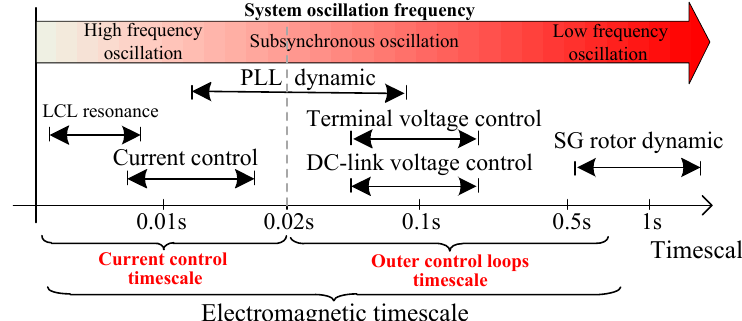
Figure 2. Timescale decomposition in VSC control loops.